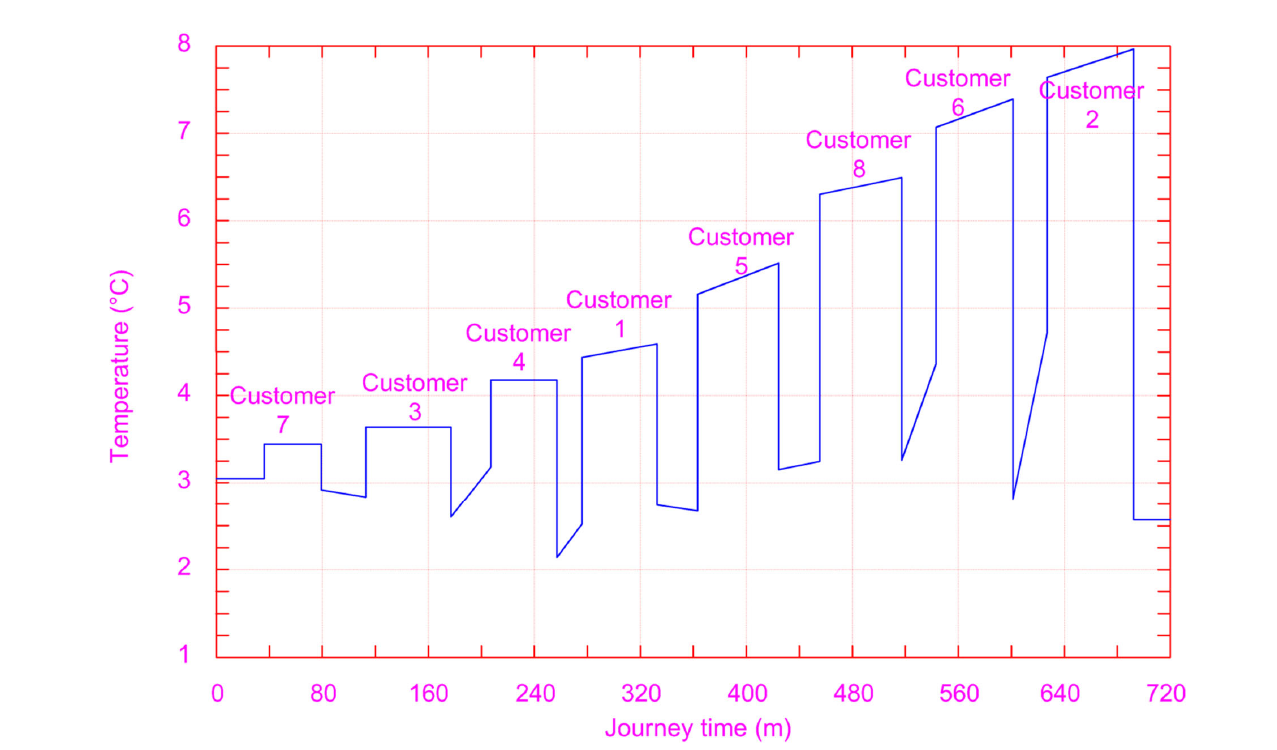
Fig.1. Temperature changes with respect to the performed route (Adapted of Novaes et al., 2015) The truck's stored mass decreases as deliveries are performed, allowing more warm air to flow into the truck. This situation causes the refrigeration system to require more work to maintain the cold chain. In this case, the need to include thermal considerations in the vehicle routing problem for refrigerated products is highlighted since energy consumption is included in the route's total